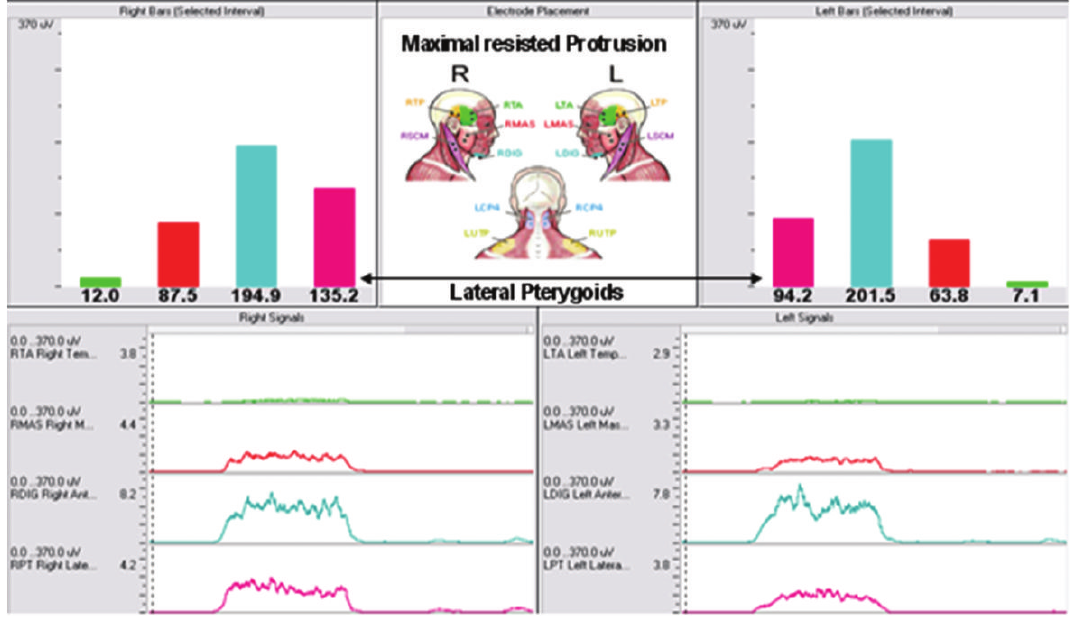
Figure 4: Recorded during jaw protrusion against resistance while the teeth are separated. Baseline values of the lateral pterygoids were normalized to this maximal